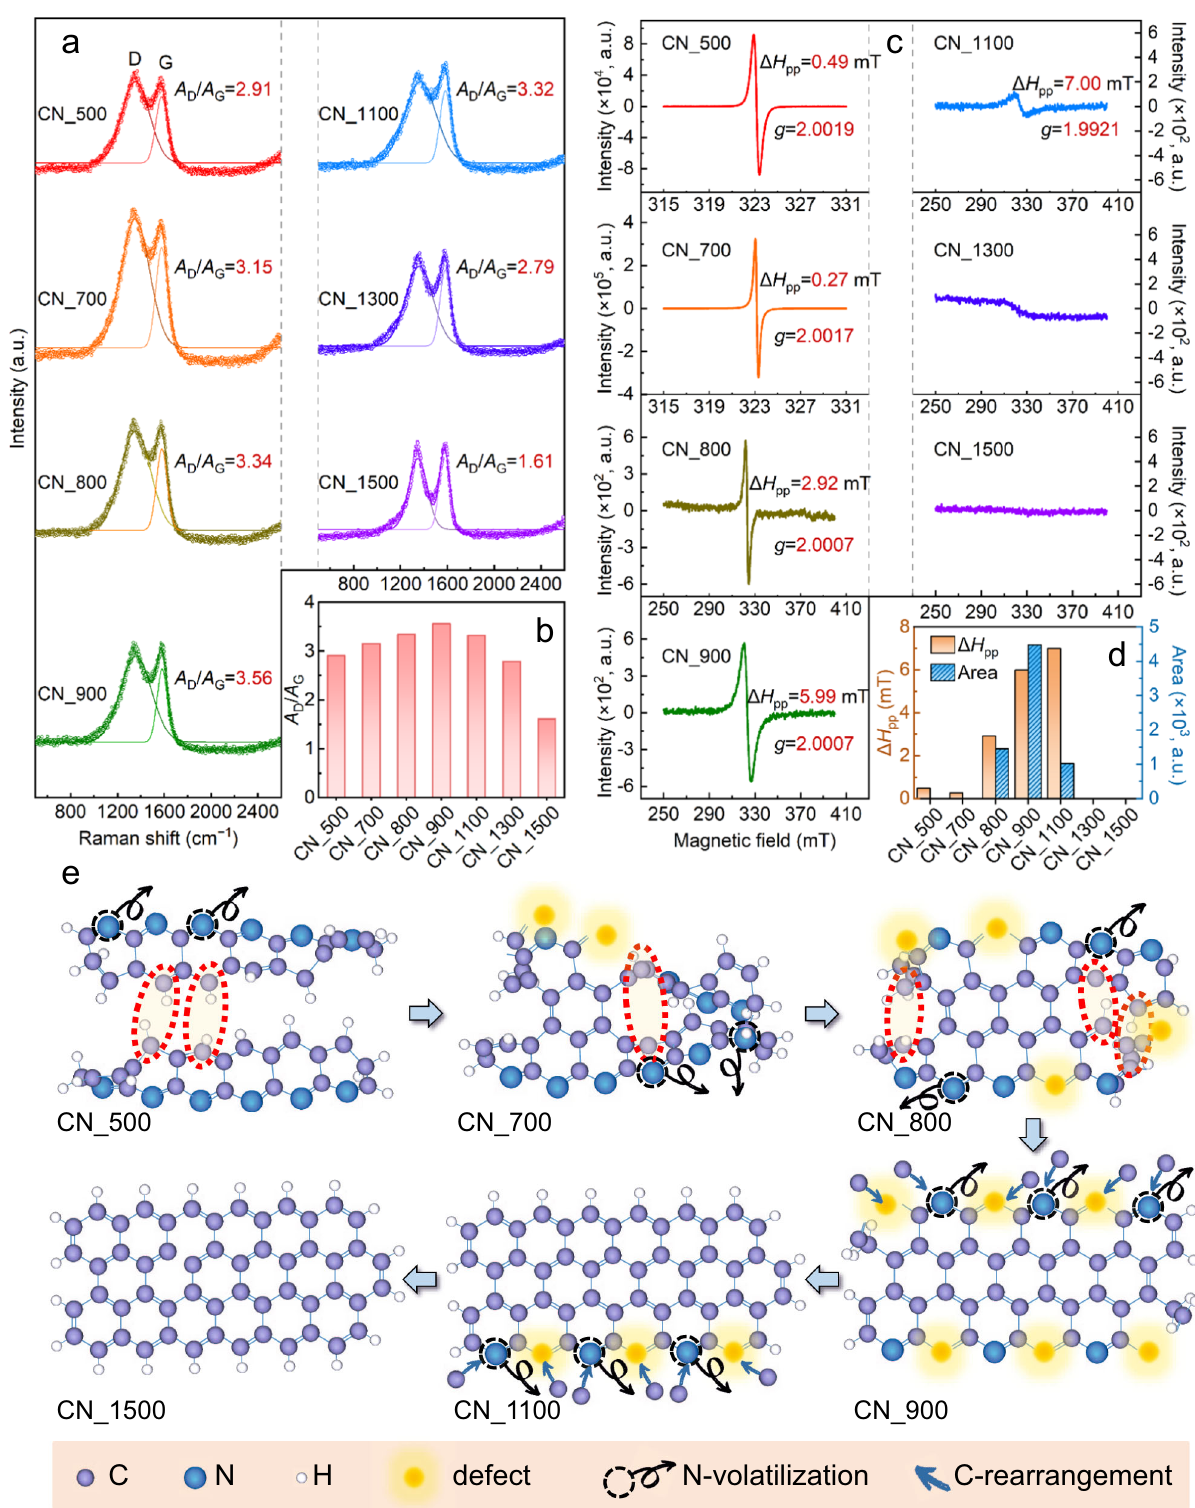
Fig. 3 | Disclosing the generation, evolution, and annihilation of defects. a Raman spectra and fi tted peak curves of the CN_500, CN_700, CN_800, CN_900, CN_1100, CN_1300, and CN_1500. b Comparison of the A D / A G ratiocalculated from Ramanspectra. c ESR spectraof the different CNs. d Comparisonofthe calculated